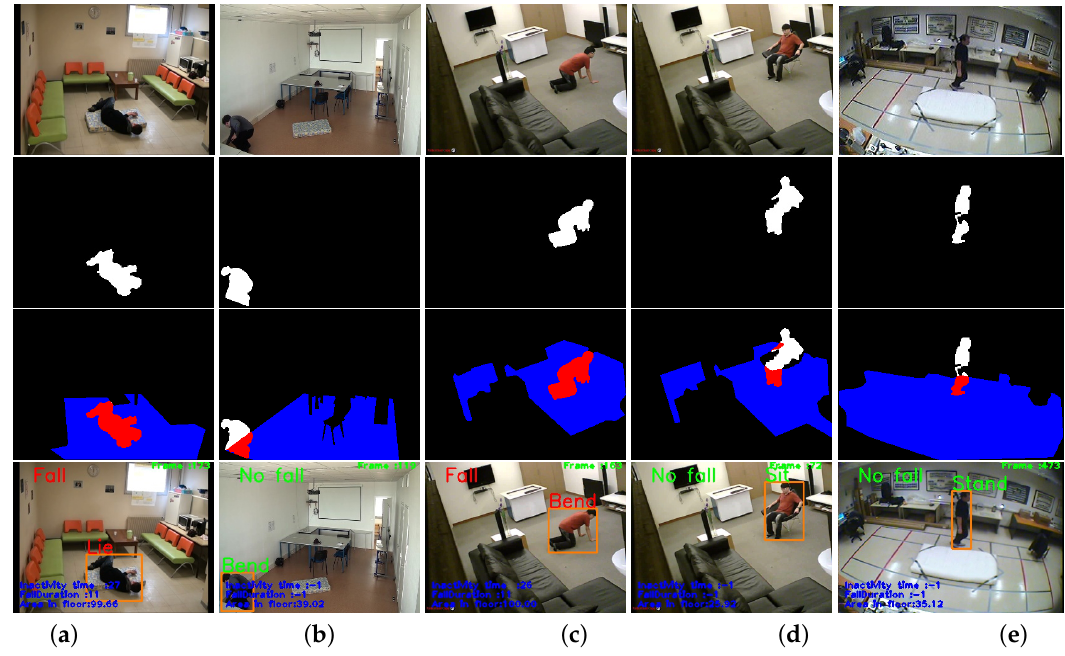
Figure 15. Illustration of fall, bend, sit, and stand activities results. Columns ( a – e ) represent fall, bending, sitting and standing activities, respectively. Rows 1–4, from top to bottom, represent reference images, human silhouettes, human silhouette with floor intersection result, and the result of our fall detection system